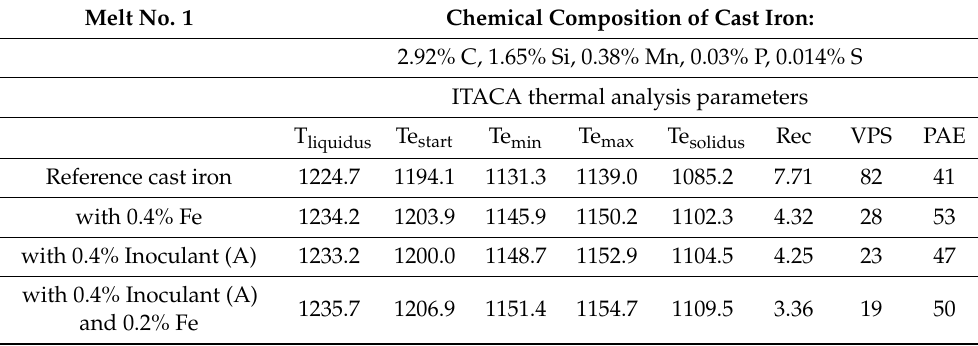
Figure 16. Grey cast iron (with 0.014% S content) with addition of 0.4% Inoculant (A): ( a ) sample etched with Picral reagent; ( b ) non-etched sample; ( c ) changes in cast iron temperature (in time, sec.) during crystallisation and cooling of casting according to ITACA system. Table 6. Cast iron crystallisation parameters obtained in thermal analysis by ITACA method in Melt No.